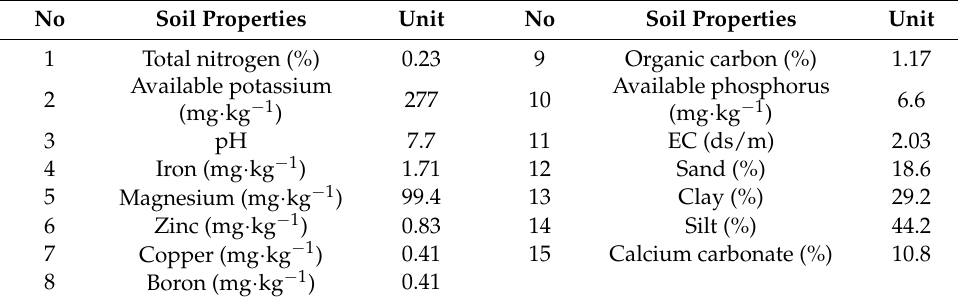
Table 1. Soil characteristics of the research